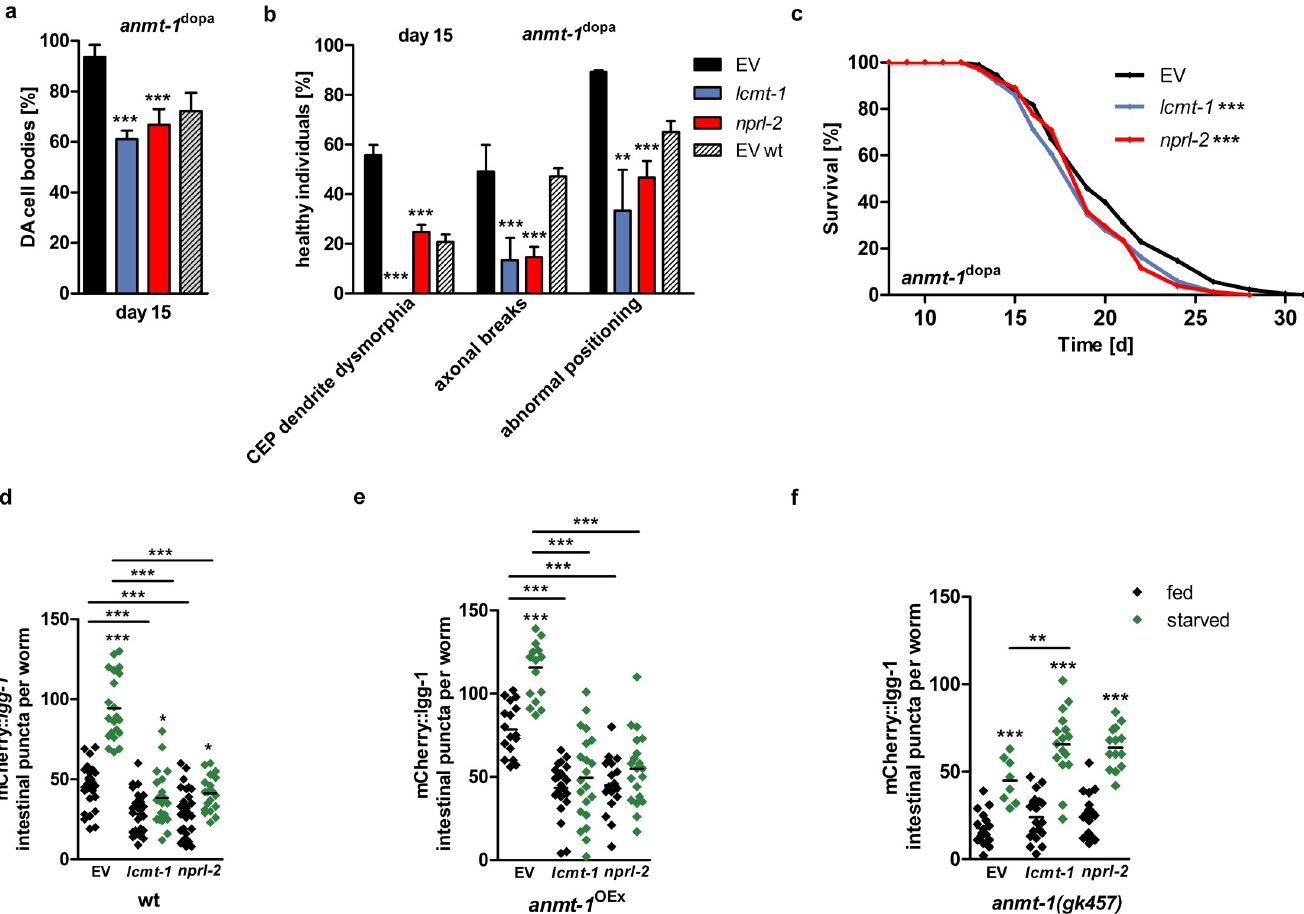
Fig 5. ANMT-1 regulates autophagy via the NPRL-2 pathway. a Presence of (DA) cell bodies in anmt-1 dopa with a neuronal RNAi-sensitive background treated with RNAi against lcmt-1 (blue) and nprl-2 (red) compared to control RNAi (EV; black) and wt EV (patterned) at day 15 of adulthood. b DA neuronal morphology in anmt-1 dopa with a neuronal RNAi-sensitive background treated with RNAi against lcmt-1 and nprl-2 compared to EV and wt EV at day 15 of adulthood. c Lifespan of anmt-1 dopa with a neuronal RNAi-sensitive background treated with RNAi against lcmt-1 and nprl-2 compared to EV. d–f Number of puncta per individual worm at day 1 treated with RNAi against lcmt-1 and nprl-2 compared to EV at day 1 of adulthood after feeding (black) or 24 h of starvation (green) in d wt, e anmt-1 OEx and f anmt-1(gk457) . �� : p < 0.01, ��� : p <